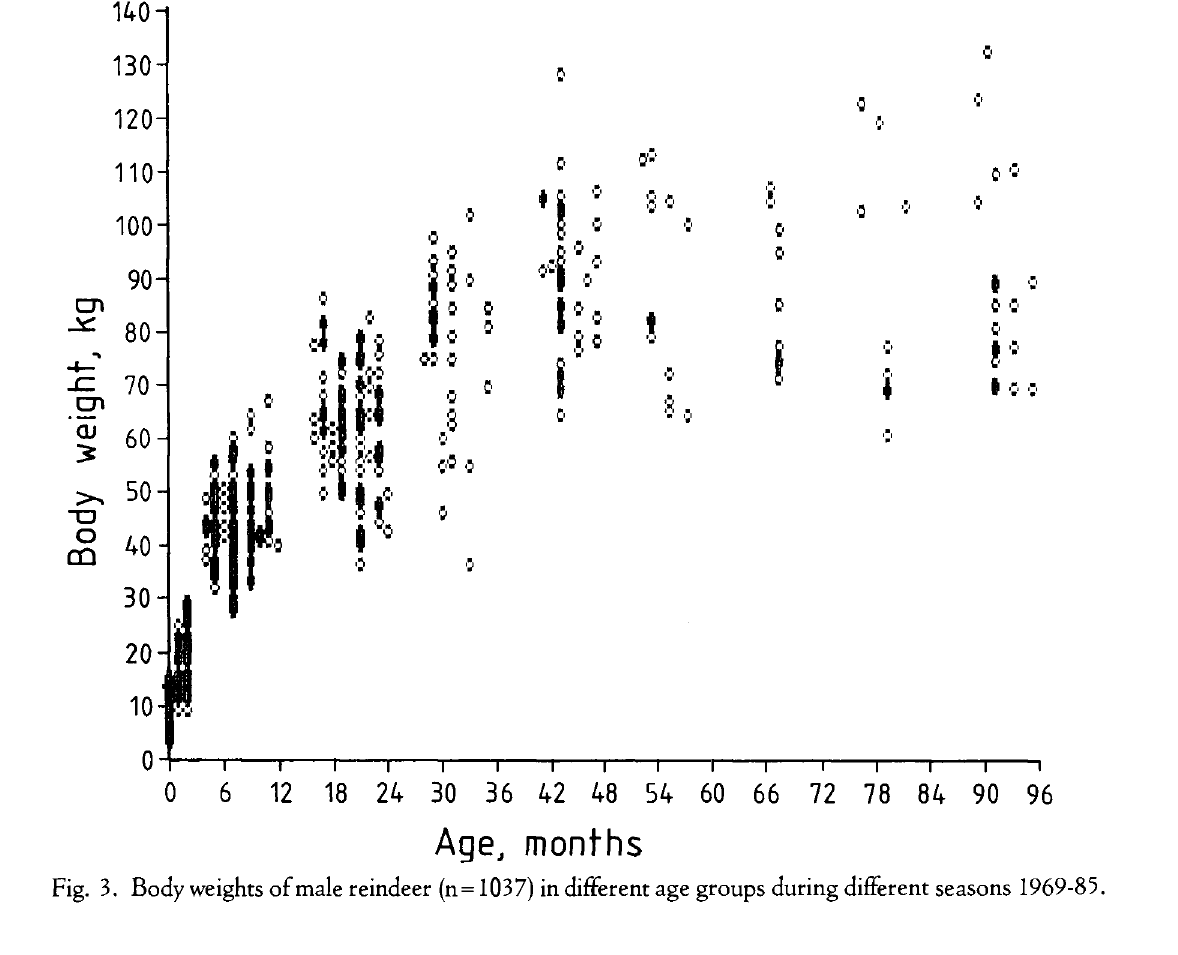
Fig. 3. Body weights of male reindeer (n= 1037) in different age groups during different seasons 1969-85.